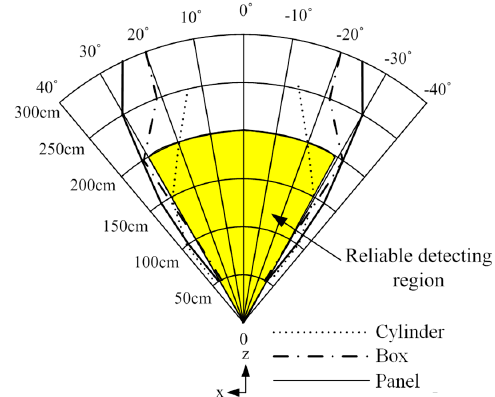
Figure 3. Detection region of one ultrasonic sensor (Each line represents the detectable region of the object, respectively).